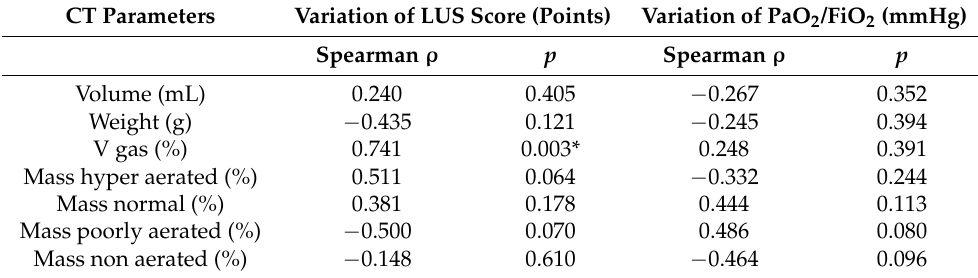
Table 2. Correlations between variation of LUS score and PaO 2 /FiO 2 and CT parameters. LUS, lung ultrasound; arterial partial pressure of oxygen (PaO 2 ); fraction of inspired oxygen (FiO 2 ); V gas, volume of gas. CT Parameters Variation of LUS Score